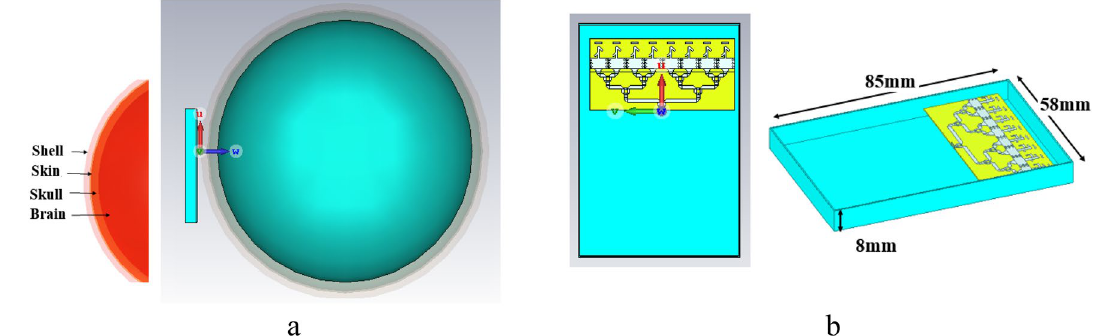
Figure 7. ( a ) Human head and handset model. ( b ) The handset dimension.